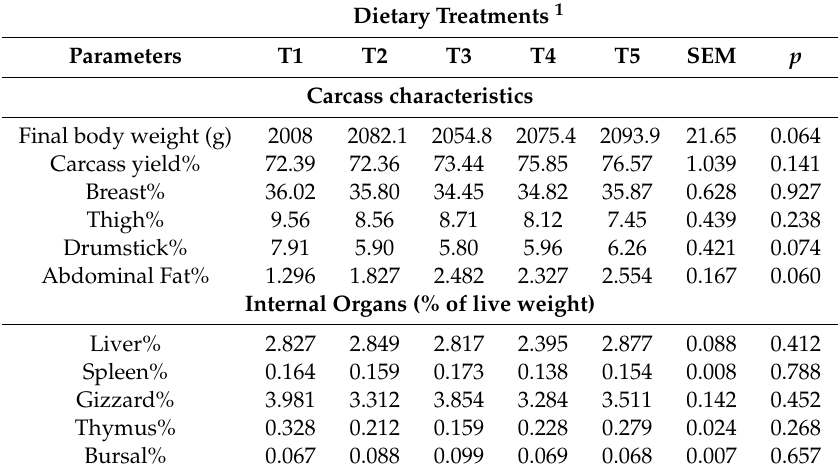
Table 2. E ff ects of inorganic selenium and di ff erent sources of bacterial selenoprotein on carcass characteristics and internal organs in broiler